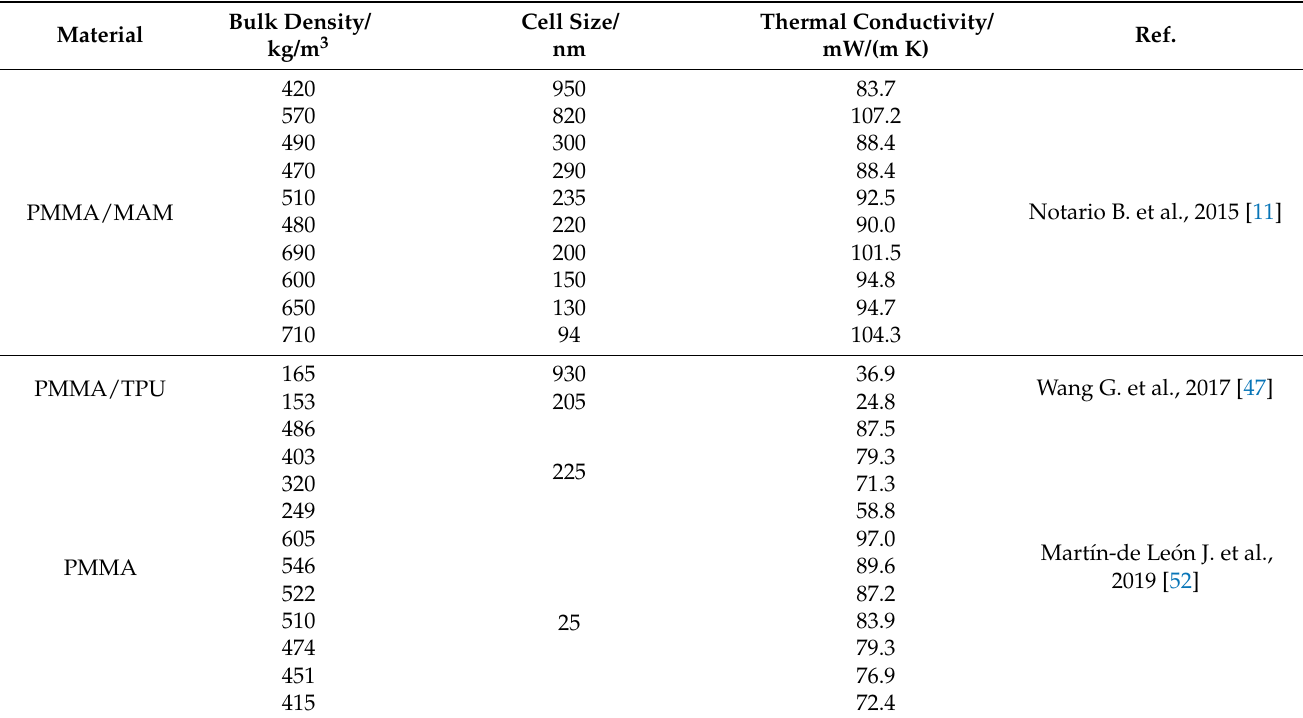
Table 3. Bulk density, cell size, and thermal conductivity of bulk nanocellular polymers in the literature. Bulk Material